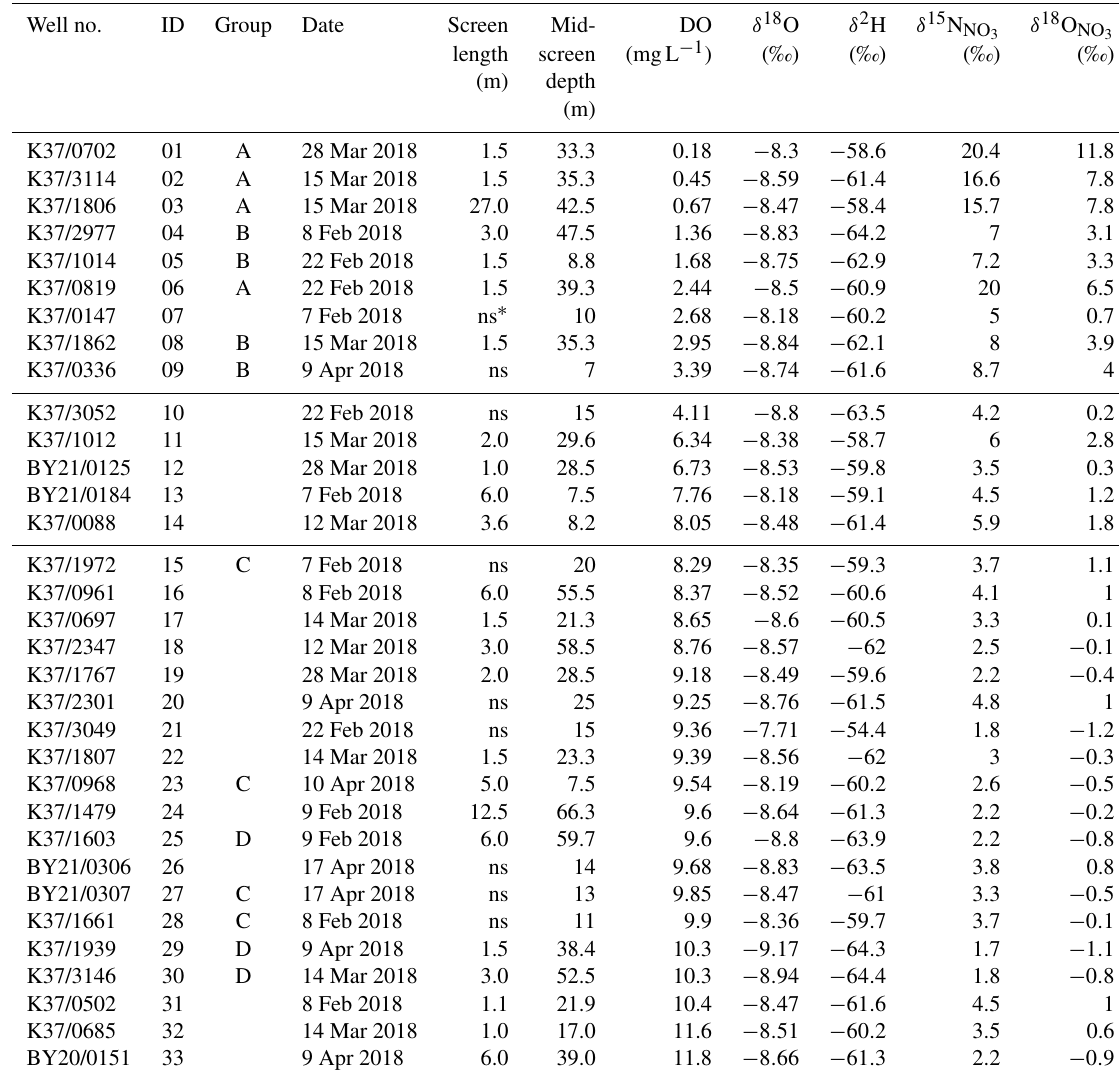
Table 1. Sample and well information, field dissolved oxygen concentration (DO), and isotopes of water and nitrate. The wells are ordered from lowest to highest DO concentrations, and four groups of samples (A to D) are identified for discussion (below). Well